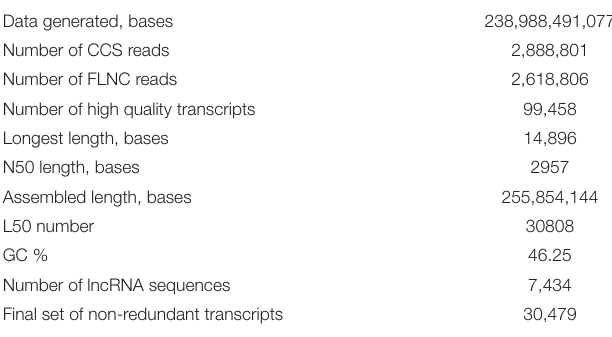
TABLE 1 | Iso-Seq data and transcriptome assembly